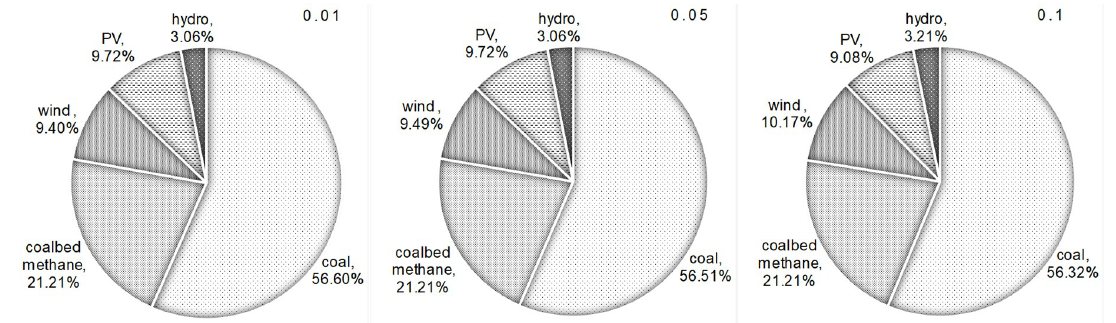
Figure 13. Power structure under different renewable energy availability confidence levels.